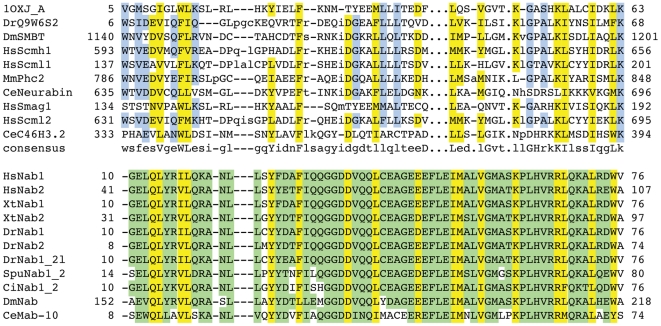
Multiple sequence alignments of remotely conserved domains in proteins identified in functional screens.Multiple sequence alignment of the Nab1 family with the SAM domain family (taken from CDD). Residues that are conserved between the two families are highlighted in yellow, those found in only one of them are highlighted in blue and green, respectively. Essential, functional residues retrieved from the CD database are indicated by hash keys. Accession numbers of sequences can be found in Supplemental Table S7.